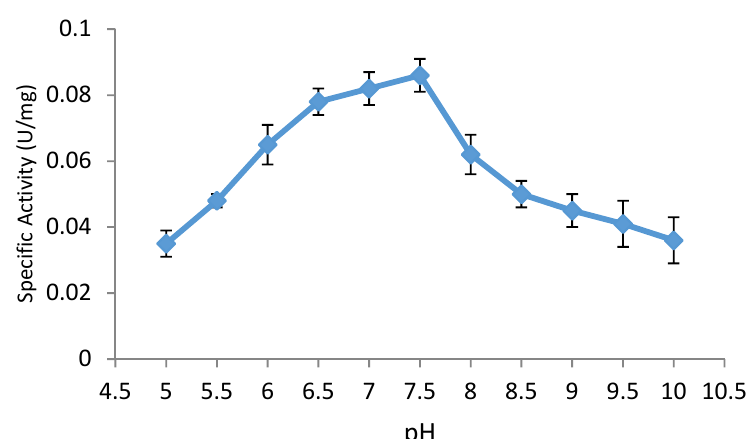
00.020.040.060.080.1 Fig. 6: The pH effect on special activity of mercuric reductase in rude cell extract by Bacillus firmus strain MN8 (Results show means of three separated experiments and indicate deviation bars) Fig. 7: The temperature effect on specific activity of mercuric reductase in crude cell extract by Bacillus firmus strain MN8